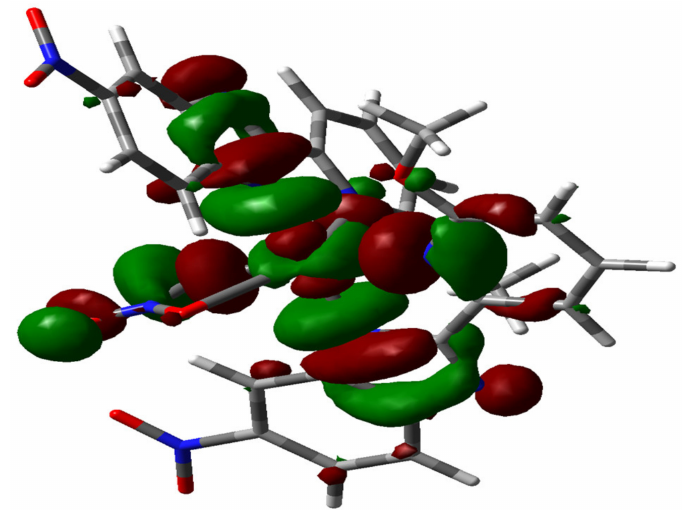
Figure 3. LUMO of complex 1 (iso value =